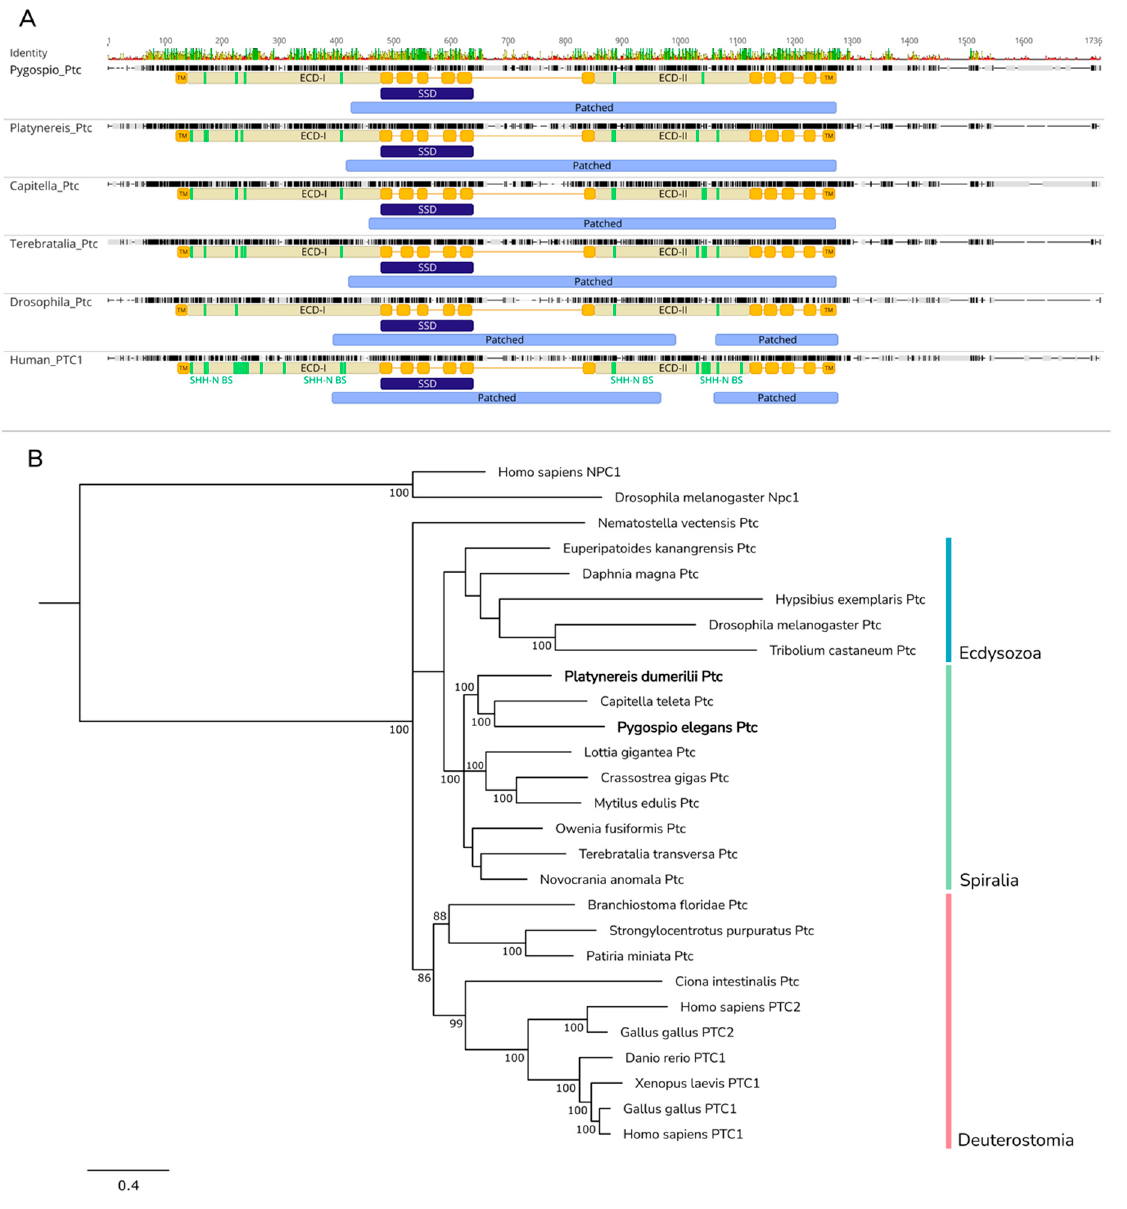
Figure 5. Multiple sequence alignment and phylogenetic analysis of Ptc proteins. ( A ) Pele-Ptc and Pdum-Ptc share a similar structure with Ptc from fruit fly and PTC1 from human, possessing a conserved Patched domain, 12 transmembrane helices (TM), and 2 extracellular domains (ECDs). TMs 2–6 form a sterol-sensing domain. Twenty-one amino acid residues of human ECDs are involved in Hh-N ligand binding (indicated by green bars). Of these, few residues are conserved between human and annelids (indicated by green bars). Patched, Patched domain (Pfam: PF02460); ECD-I and ECD-II, extracellular domains; TM, transmembrane domain; SSD, sterol-sensing domain; Hh-N BS, Hh-N-binding site. ( B ) Bayesian phylogenetic analysis was performed on amino acid sequences containing all 12 TMs, including the conserved Patched domain. Niemann–Pick C1 proteins from fruit fly and human were used as an outgroup. Numbers near branch nodes indicate Bayesian posterior probabilities. Bayesian posterior probability values less than 75 are not shown.